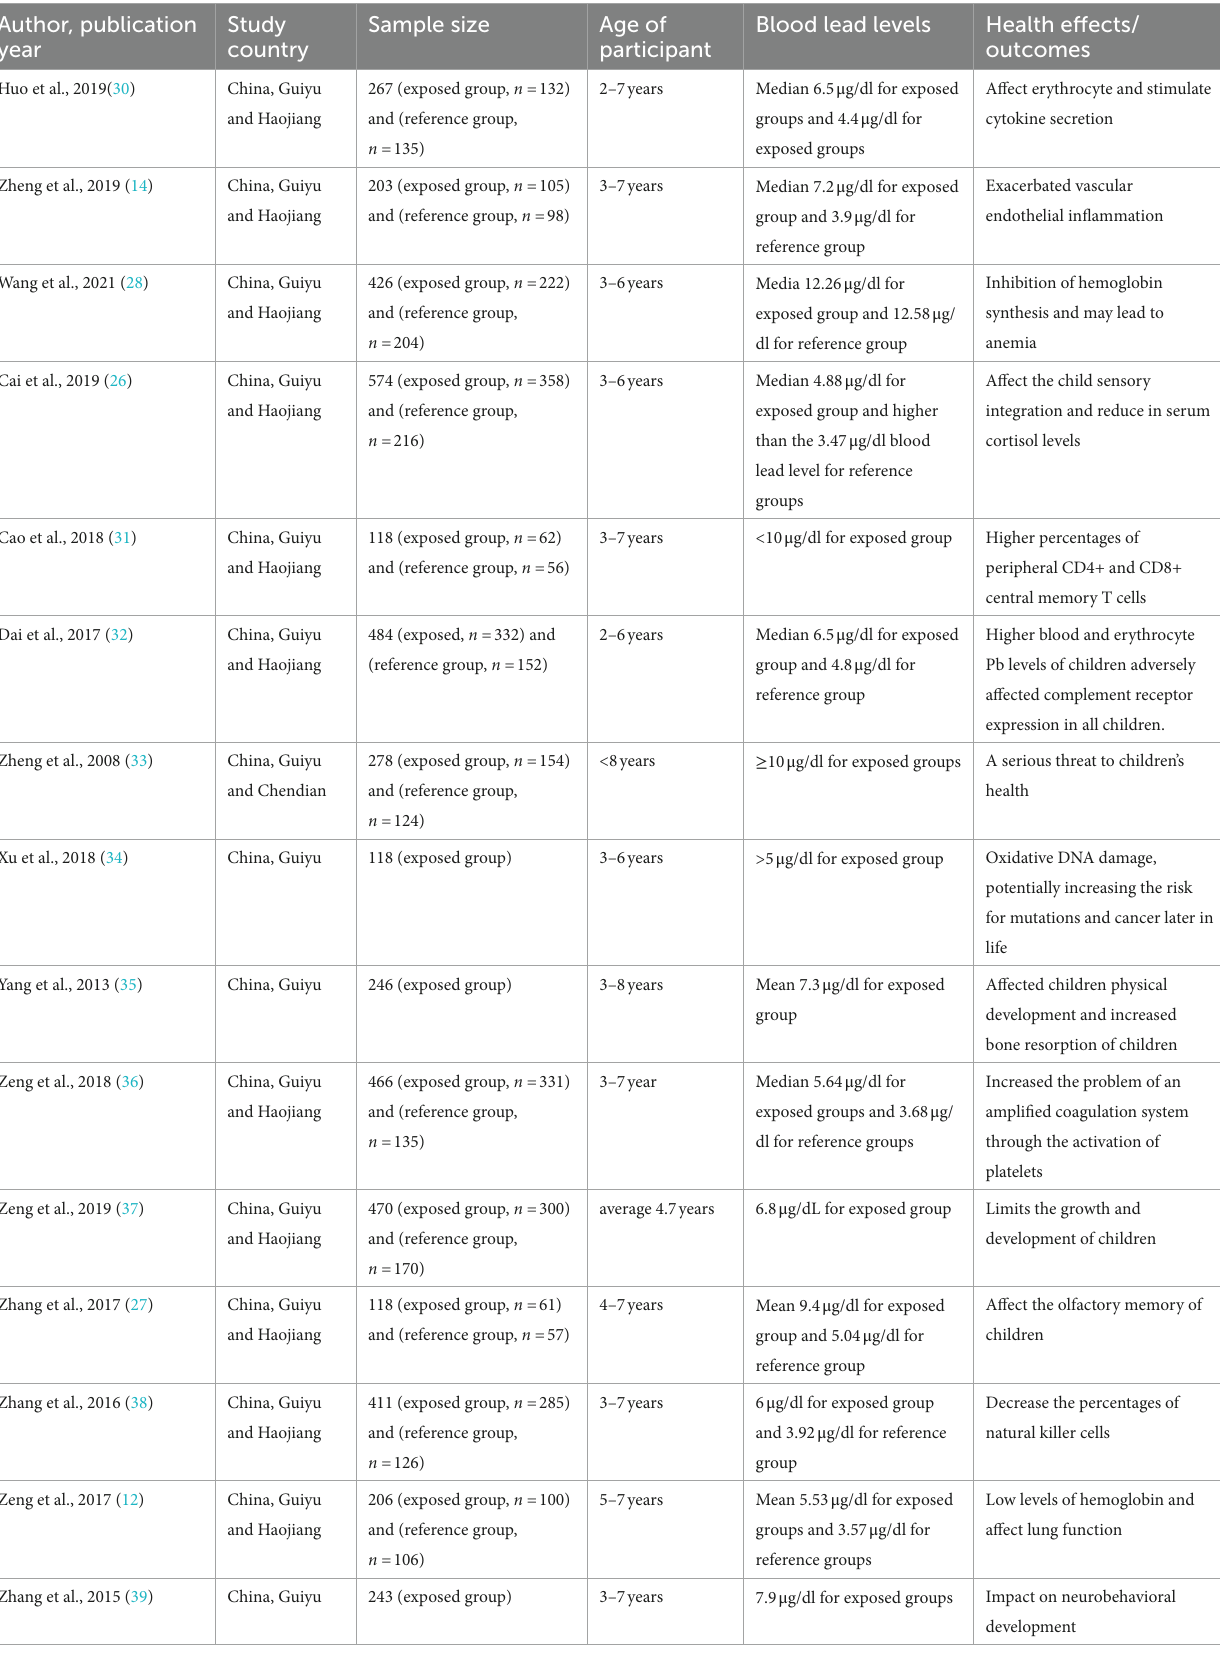
TABLE 1 Summary of 20 articles included in the review process of the health effects of Pb exposure from e-waste in